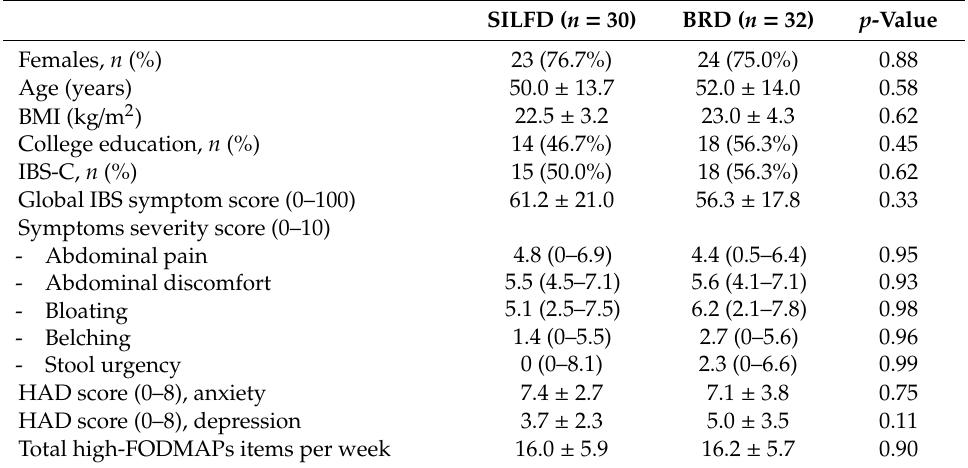
monosaccharides, and polyols.